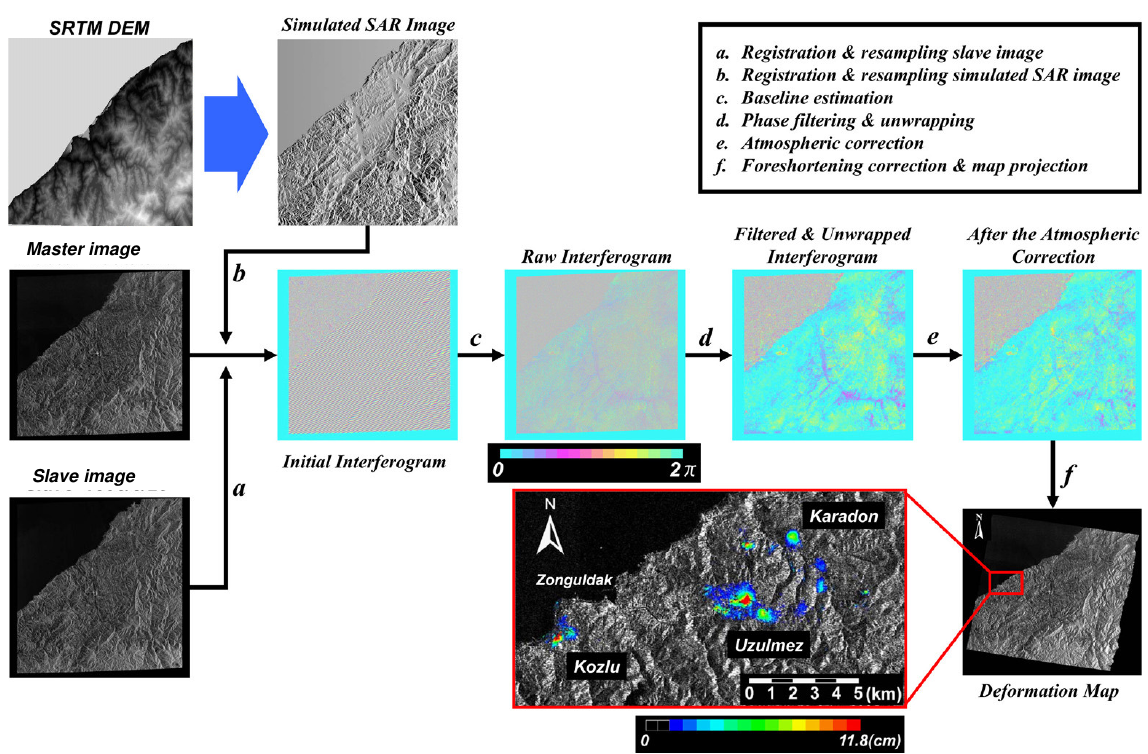
Figure 4. D-InSAR processing procedure used in this study [22]. Fig. 4. D-InSAR processing procedure used in this study (Deguchi et al. 2006).